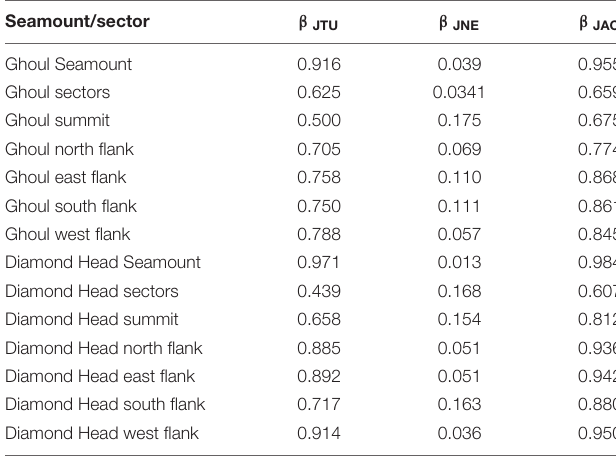
TABLE 3 | Calculated multiple site beta diversity values for: (1) each seamount, (2) across sectors (i.e., summit and north, east, south, and west flanks) within each seamount, and (3) separately for each